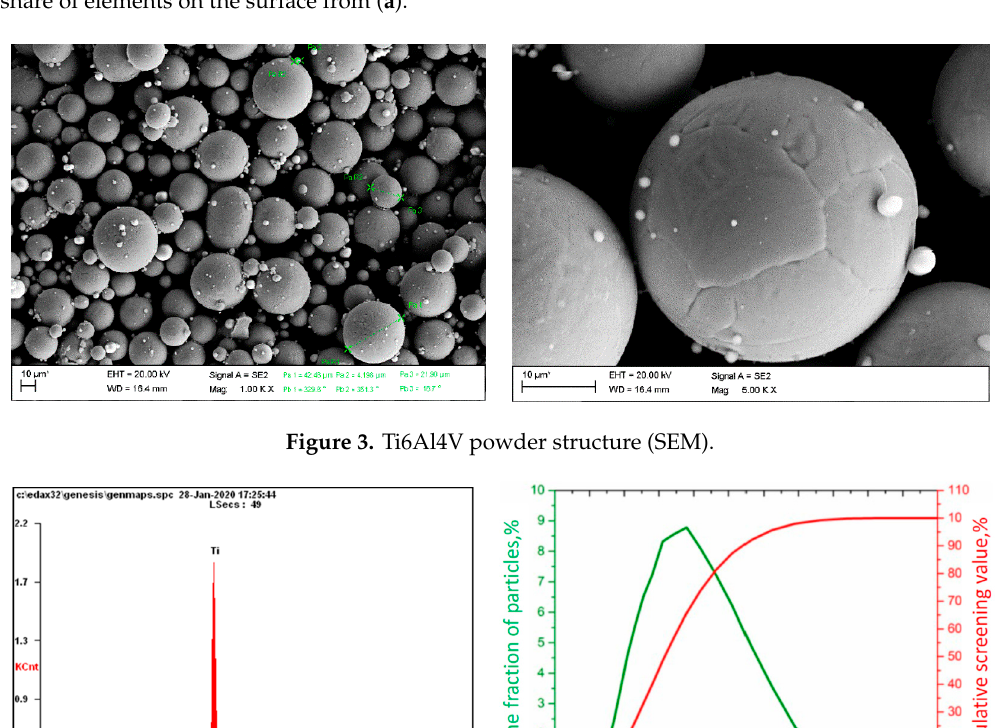
Figure 2. ( a ) Surface structure of the Ti6Al4V disc (scanning electron microscopy, SEM); ( b ) volume share of elements on the surface from (a).